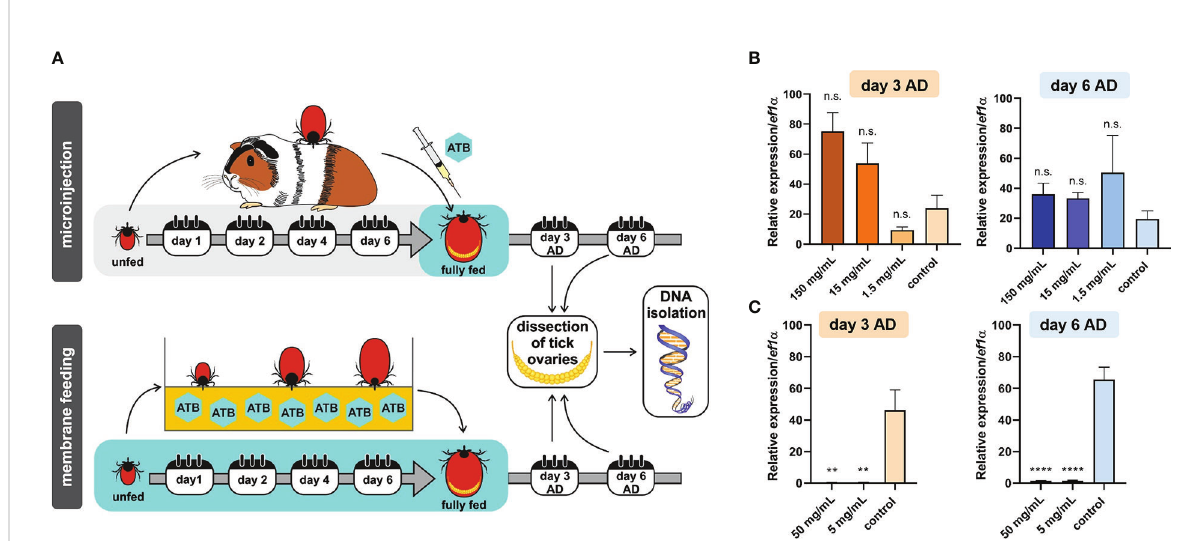
FIGURE 1 (A) Scheme of tetracycline antibiotics (ATB) administration (microinjection or ex vivo membrane feeding) and a timeline of DNA extraction from tick ovaries after tick detachment (AD). (B) Microinjection. Real-time PCR on DNA extracts from individual tick ovaries determining the levels of Mitochondria mitochondrii upon tetracycline microinjection into hemolymph of Ixodes ricinus females fully engorged in vivo . (C) Membrane feeding. Real-time PCR on DNA extracts from individual tick ovaries determining the levels of M. mitochondrii upon tetracycline supplementation of blood meal during ex vivo membrane feeding of I. ricinus ticks. (B, C) Stock concentrations of tetracycline are shown. Mean and SEM are shown, (B) n = 3 ticks, (C) n ≥ 9 ticks. T-test analysis: **p < 0.005; ****p < 0.0001; n.s., not signi fi